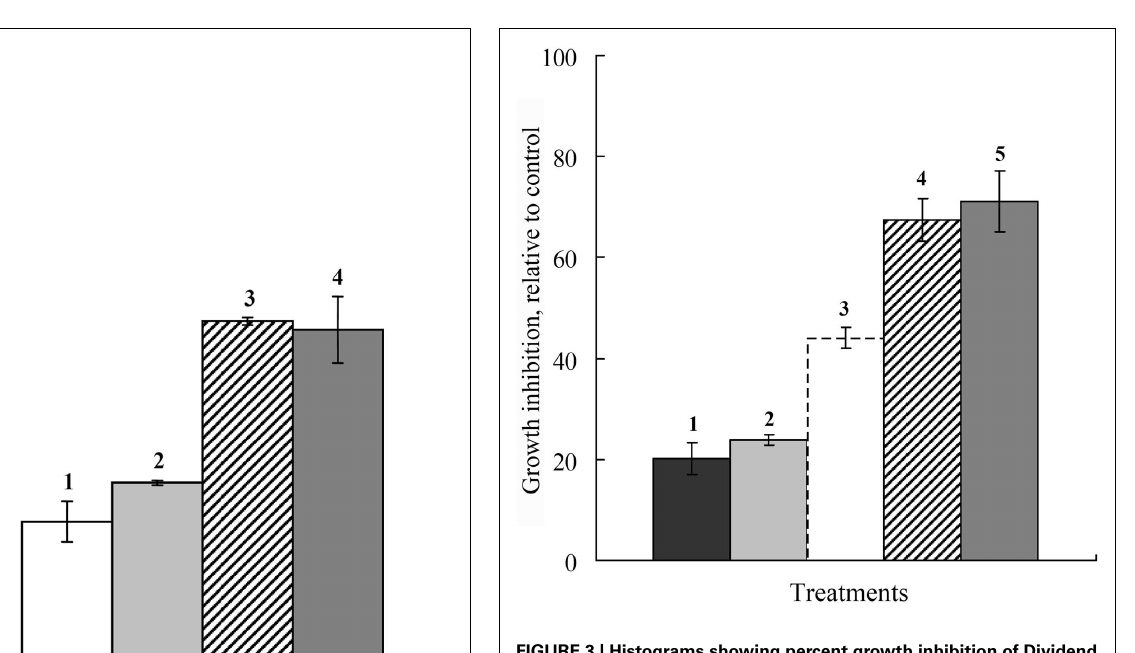
FIGURE 3 | Histograms showing percent growth inhibition of Dividend and thymol used individually or in combination against B. sorokiniana . (1) Thymol, 10ppm alone; (2) Dividend, 1ppm alone; (3) predicted growth inhibition based on sums of 1 and 2; (4) co-application of Dividend, 1ppm with thymol, 10ppm; (5) Dividend, 10ppm. Histograms represent average percent inhibition of two independent experiments of each treatment done in triplicate. Bars represent